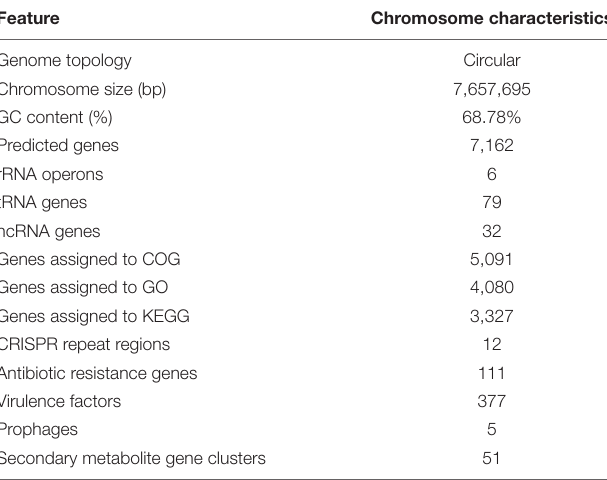
TABLE 3 | Genomic features of YIM 96748 T